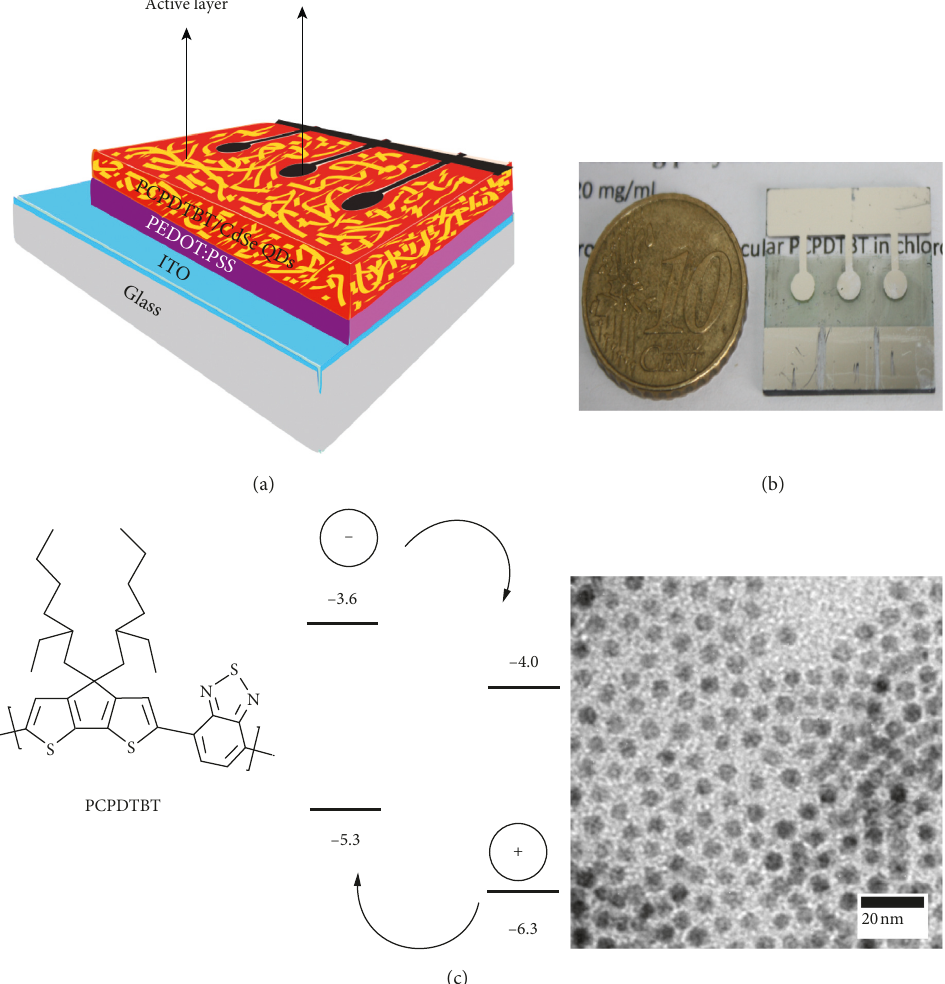
Figure 1: (a) Design structure, (b) photograph of fabricated solar cell devices, (c) chemical structure of PCPDTBT, and a TEM image of CdSe QDs as well as their energy level diagram in the photoactive layer. The image was adapted from [16].